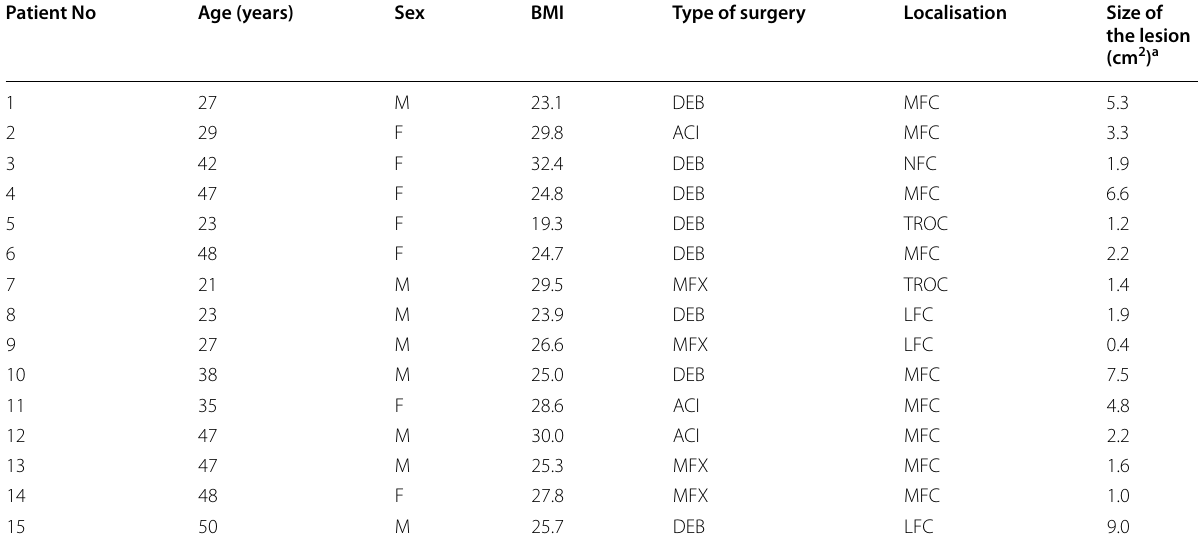
Table 2 Demographic characteristics and frequency distribution of the patients and treated lesions